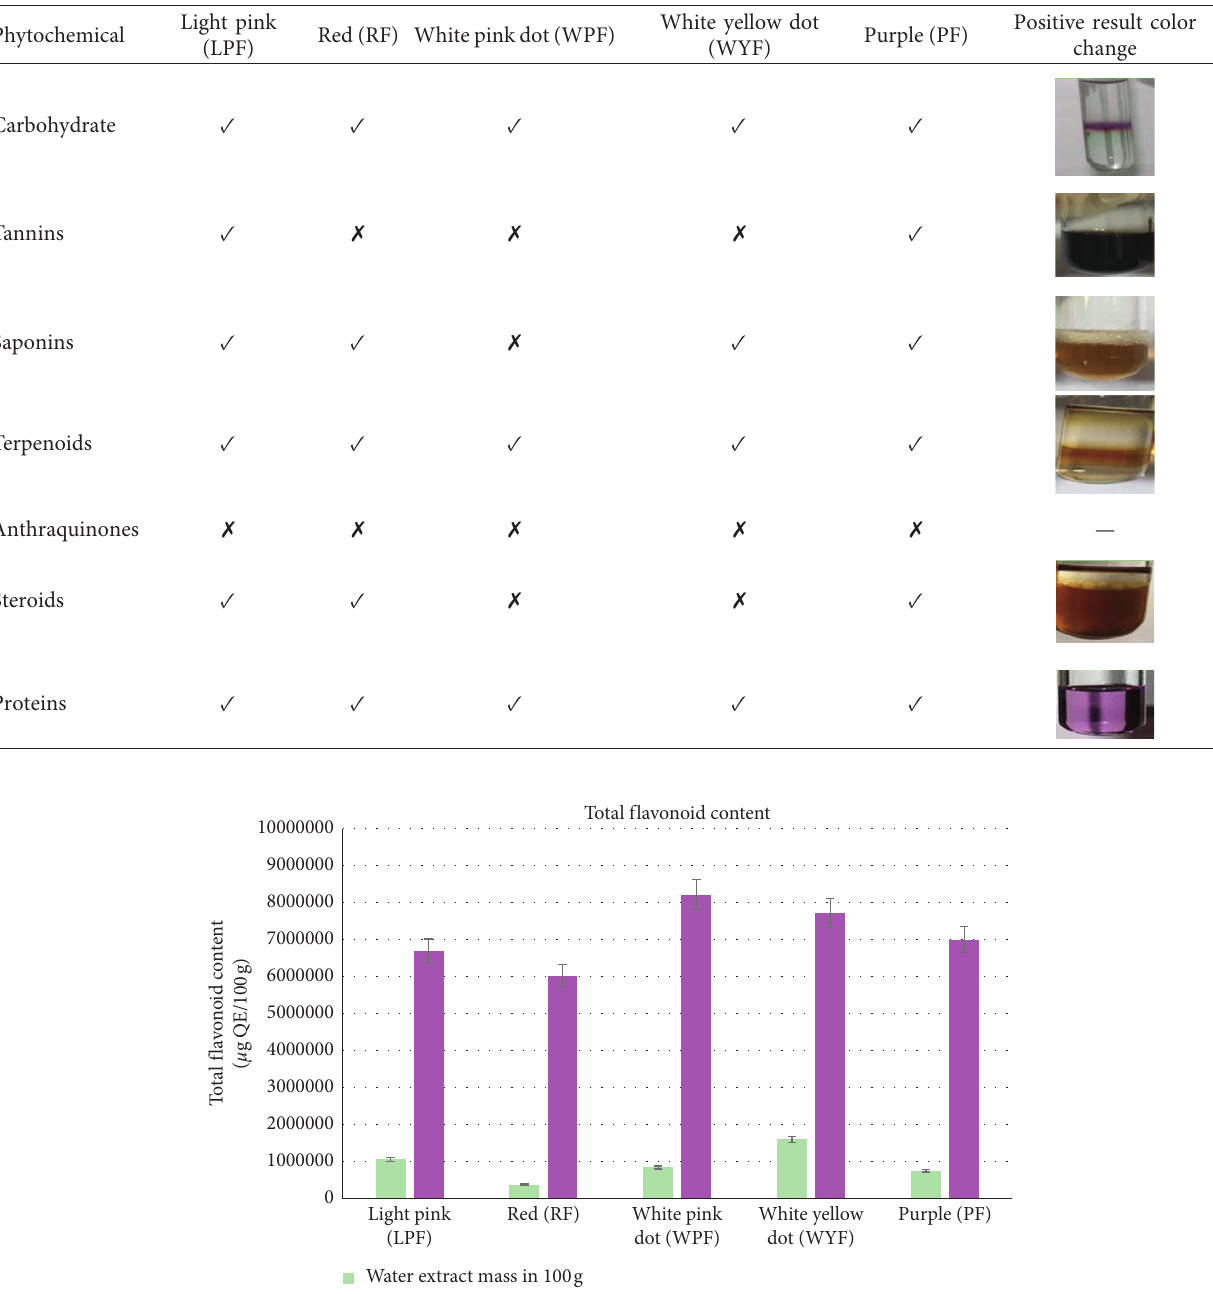
Table 3: Phytochemical analysis test